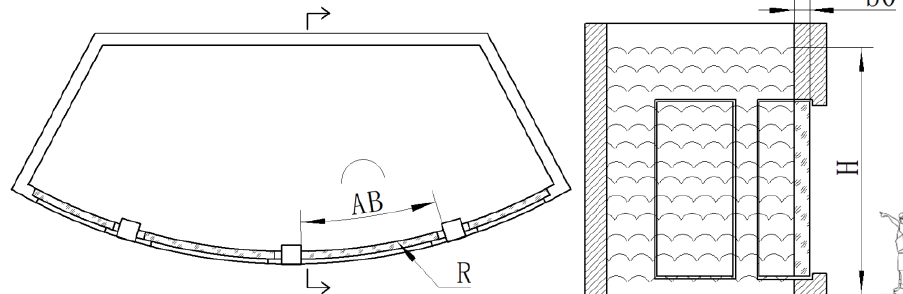
Figure 10. Aquarium structure and variables. Table 5. Random variables of the aquarium.